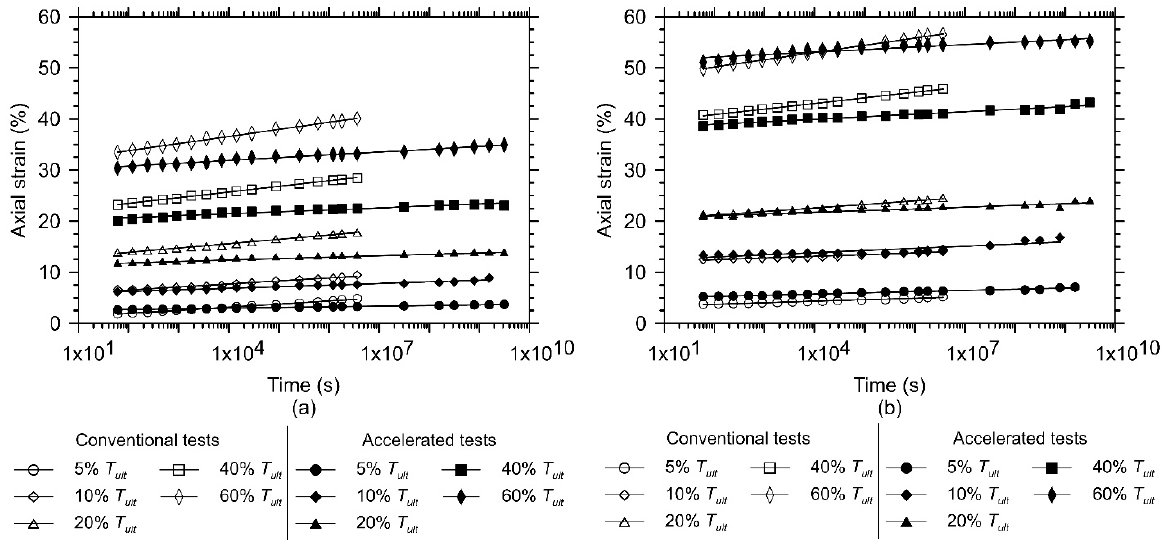
Figure 4. Mean creep behaviour of the non-woven needle-punched geotextile manufactured with ( a ) continuous filaments (GTXnwC) and ( b ) short-staple fibres (GTXnwS); based on three and four specimens submitted to the conventional and accelerated creep tests, respectively. Table 2. Values of creep strain rate, parameter “b” and coefficients of determination of the best-fit regression lines that represent the geotextiles’ mean creep behaviour for the conventional and ac- celerated creep tests performed at each load level investigated.